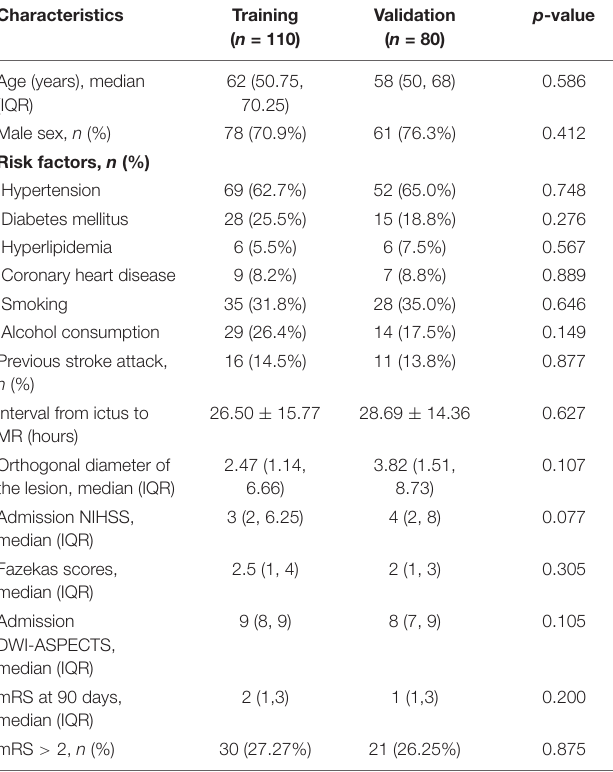
TABLE 1 | Population characteristics of patients with AIS in the training and validation sets. TABLE 2 | Population characteristics of AIS patients with favorable and